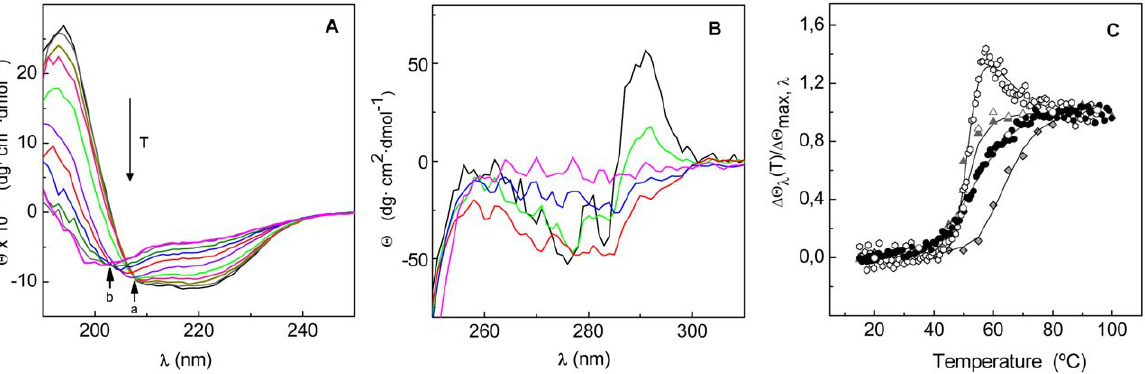
Figure 2. Dependence of Cpl-7 CD spectra with temperature at neutral pH. ( A ) and ( B ) show the spectroscopic changes induced by the temperature increase in the far- and near-UV regions, respectively. Isodichroic points in the far-UV region are marked as ‘‘a’’ and ‘‘b’’, and the T arrow indicates the temperature increase (20, 30, 40, 45, 50, 55, 60, 65, 70, 85 and 95 u C). The near-UV spectra correspond to 20 u C (black), 50 u C (green), 55 u C (blue), 65 u C (red) and 95 u C (magenta). ( C ) compares the thermal denaturation profiles of Cpl-7 at 195 nm (circles), 203 nm (triangles), 208 nm (diamonds) and 290 nm (hexagons). Measurements were performed in 20 mM Pi buffer, pH 7.0, at heating rates of 20 u C h 2 1 (solid symbols) and 40 u C h 2 1 (open